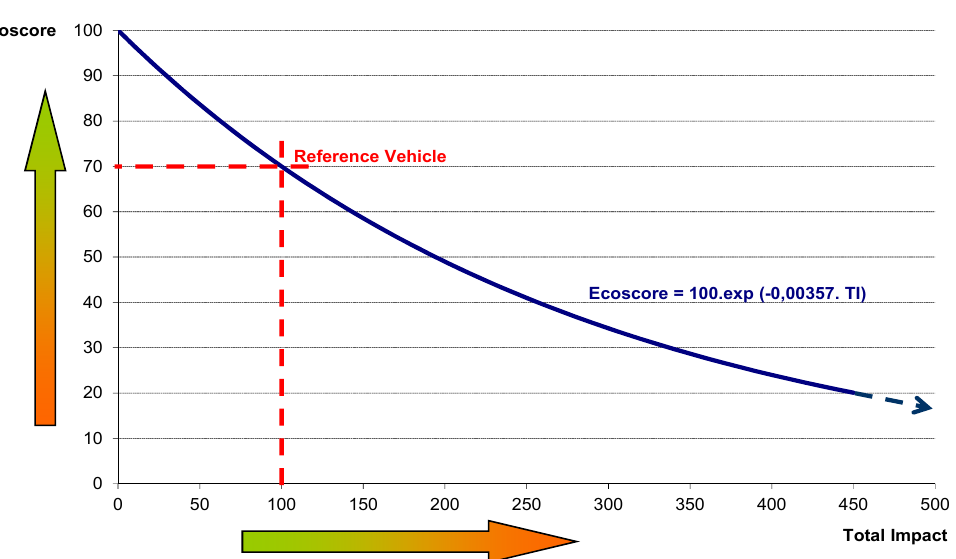
Figure 4. Transformation of total impact to Ecoscore